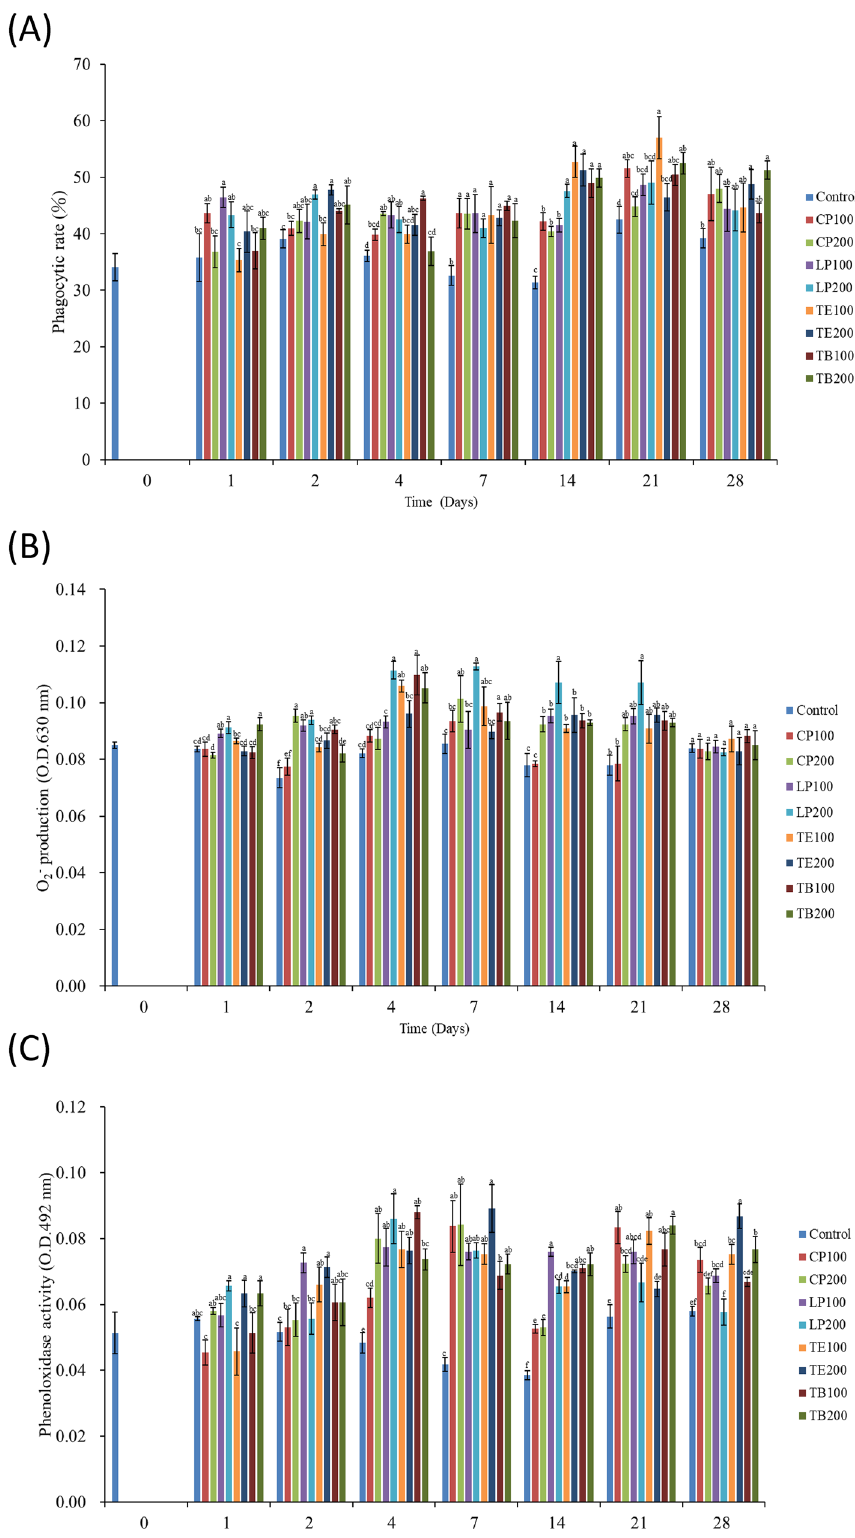
Figure 4. Effects of dietary AST on nonspecific immune response of white shrimp haemocyte. ( A ) Phagocytic rate, (B ) superoxide anion production rate, and ( C ) phenoloxidase activity. One-way ANOVA and Tukey’s test were performed to compare the differences between groups at indicated time point. Significant differences ( p < 0.05) between groups are indicated by different letters above bars. The data are expressed as mean ± standard deviation (n =